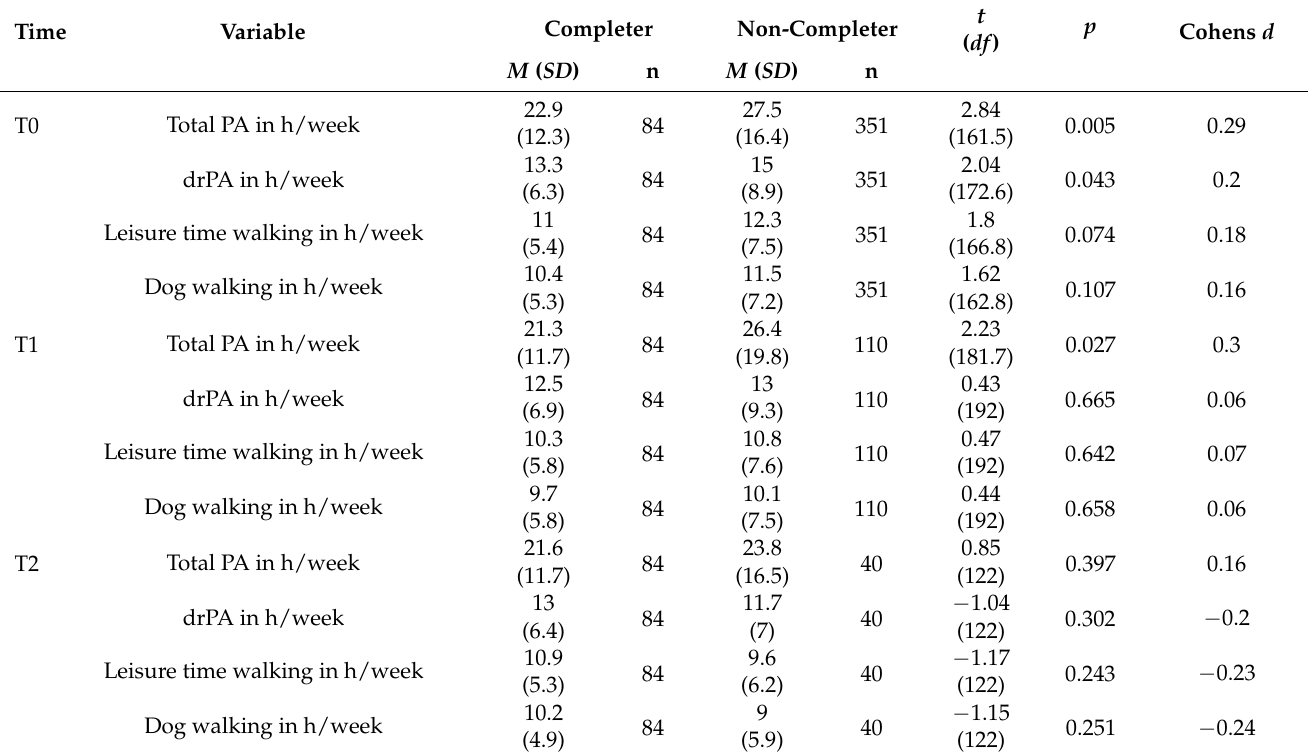
Table 6. Differences in PA between completers and non-completers.